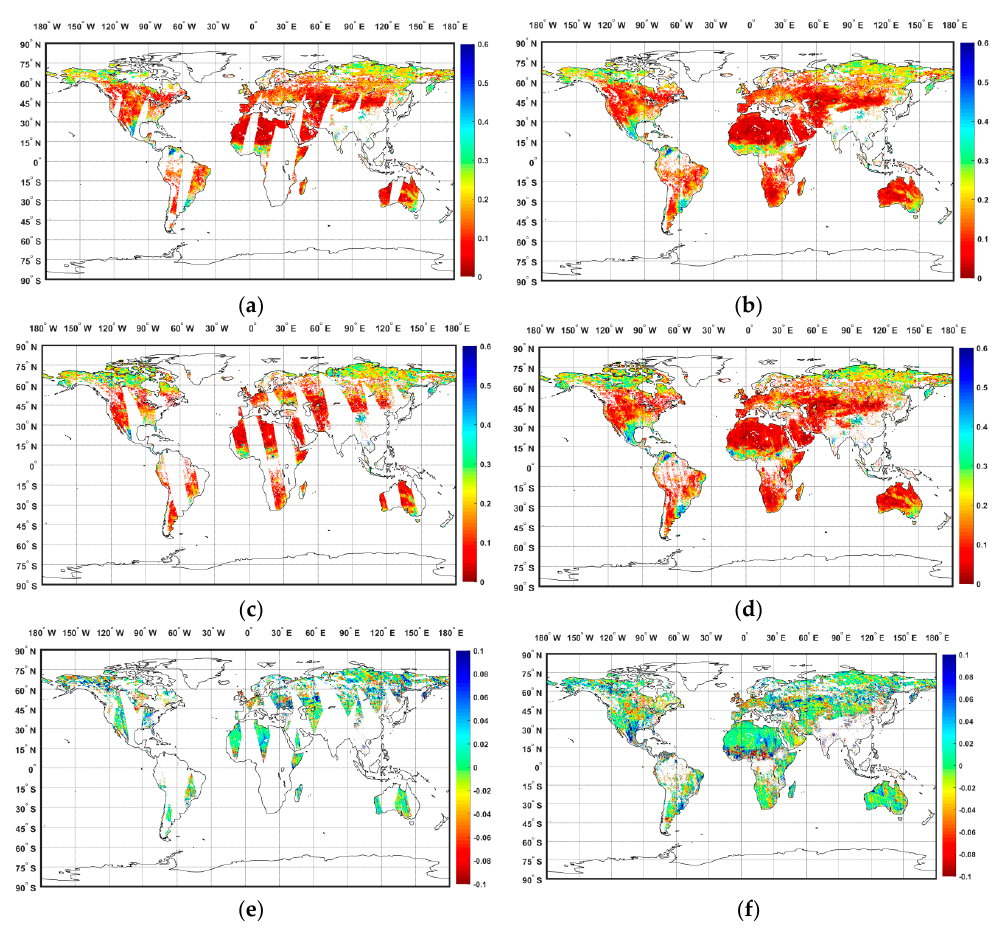
Figure 2. Global soil moisture maps on 2 July 2010. ( a , b ) NNsm ( c , d ) corresponding SMOSL3sm ( e , f ) difference value of NNsm and SMOSL3sm. The left panels ( a , c , e ) show daily data and the right panels ( b , d , f ) show 3-day average data.